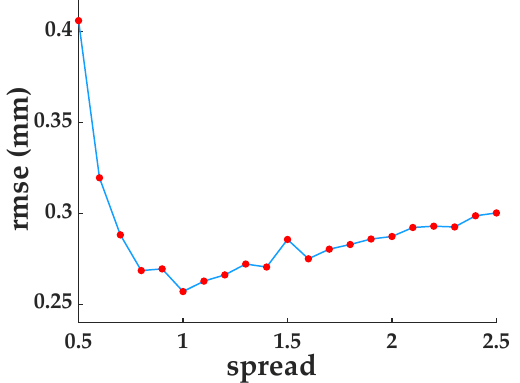
Figure 11. Influence of spread value on network precision.